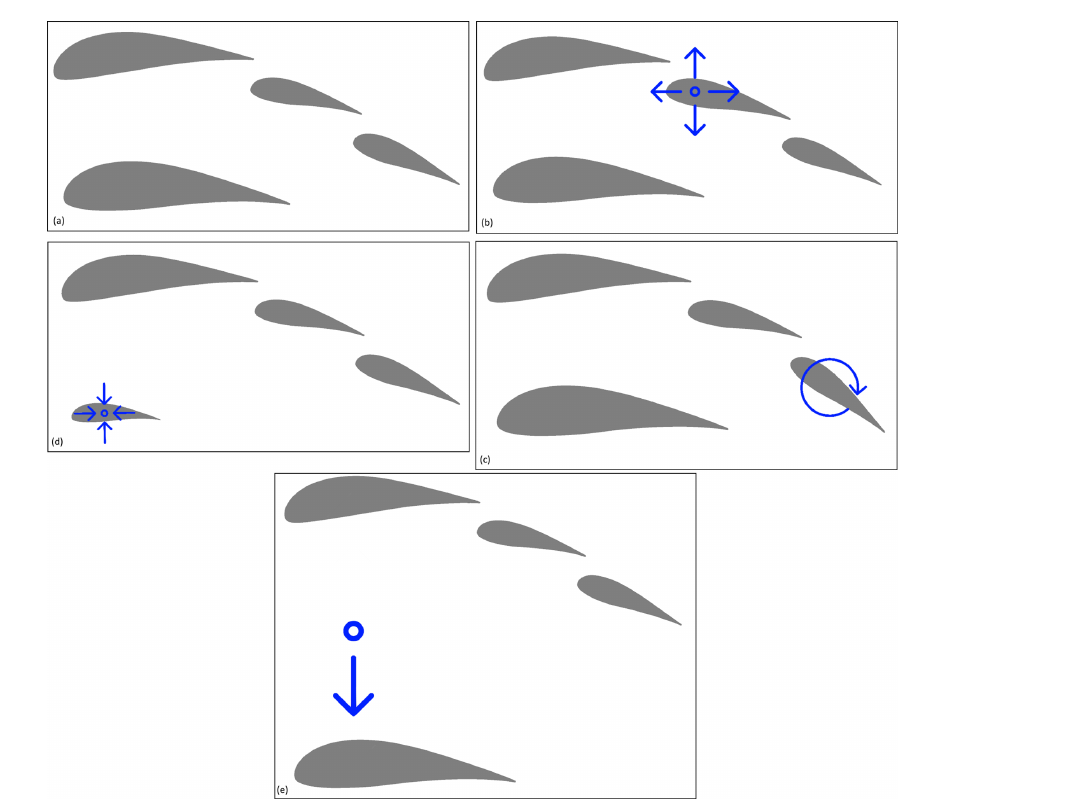
Figure 18. (a) Original geometry; (b) example of geometry with greater front-flap scale (140%); (c) example of geometry with steeper rear-flap angle ( − 10 ◦ ); (d) example of geometry with smaller strut scale (40%); (e) example of geometry with greater distance between main element and strut (275%).